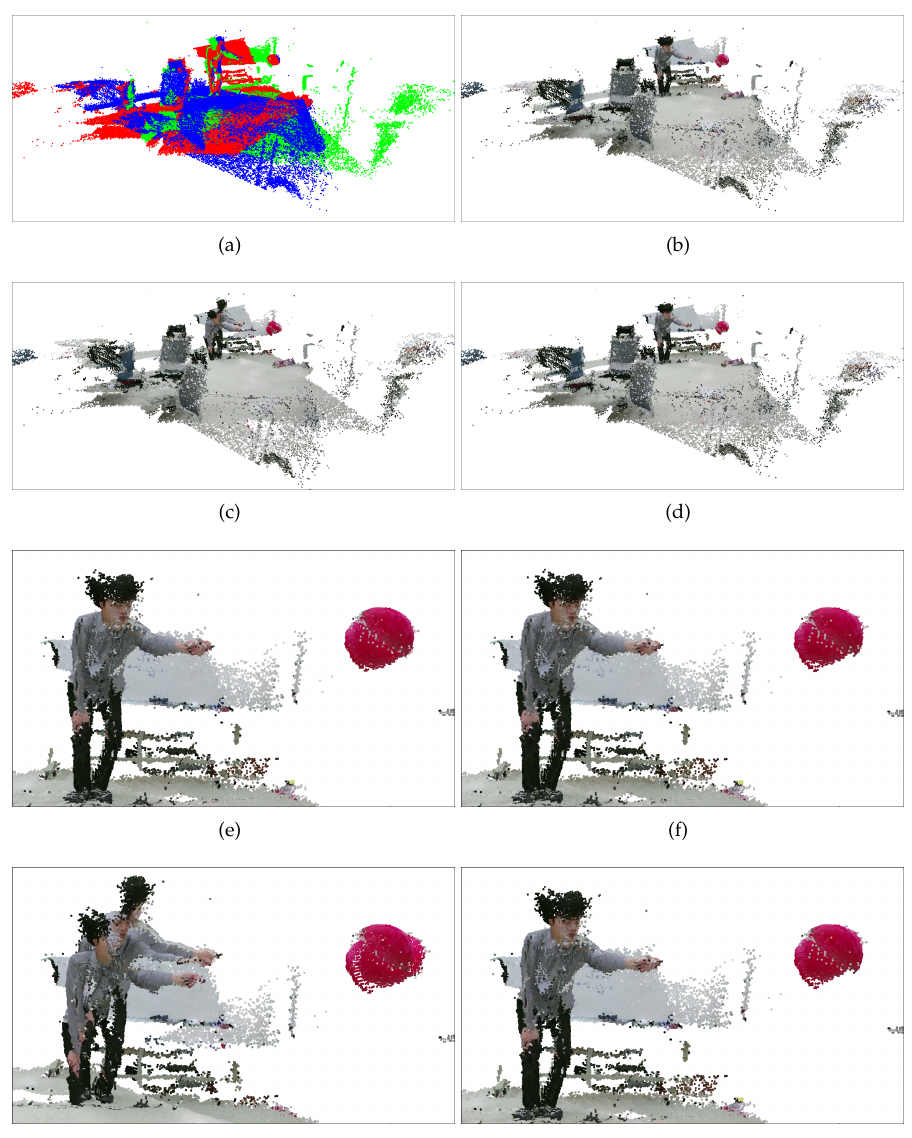
Figure 18. Rendering results (dynamic set). ( a ) Overview of the environment. 3D point clouds from different cameras have been drawn in different colors. ( b ) Proposed method (BA). ( c ) Su et al. [20]. ( d ) Su et al. (inlier set). ( e ) Proposed method (pairwise). ( f ) Proposed method (BA). ( g ) Su et al. [20]. ( h ) Su et al. [20] (inlier set). Refer to the text for more detail. Best viewed in